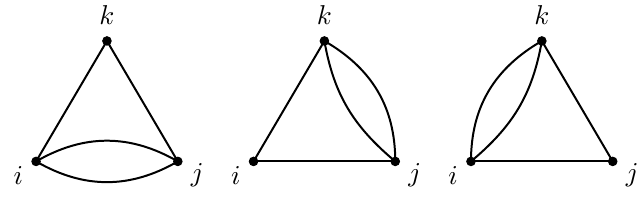
Figure 4 . Graph representation of one class of contributions of the correlator of four twist operators to I 4 when the twist operators have non-trivial support on three sheets. In the above graph, vertices represent sheets while lines represents operators on particular